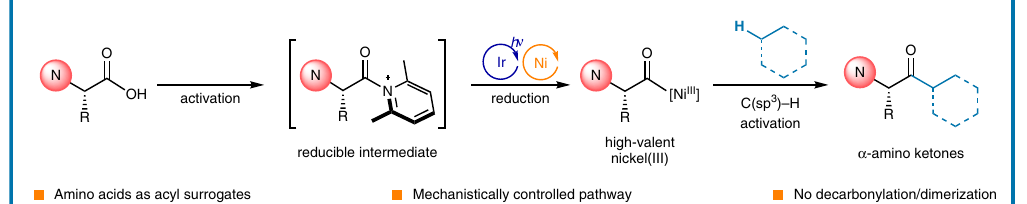
C(sp 3 ) – Hacylation.Cy= cyclohexyl as arepresentative alkylgroup of a C(sp 3 ) – Hsubstrate. c